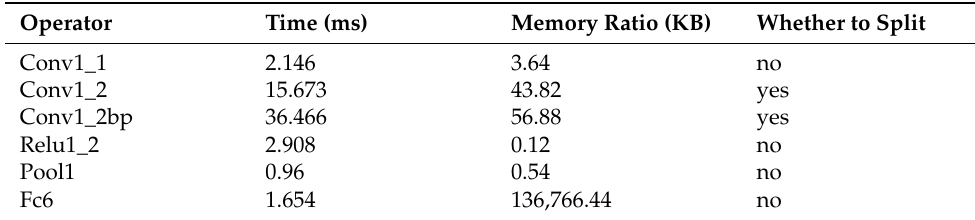
Table 6. Operator Split Decision in Vgg_16.